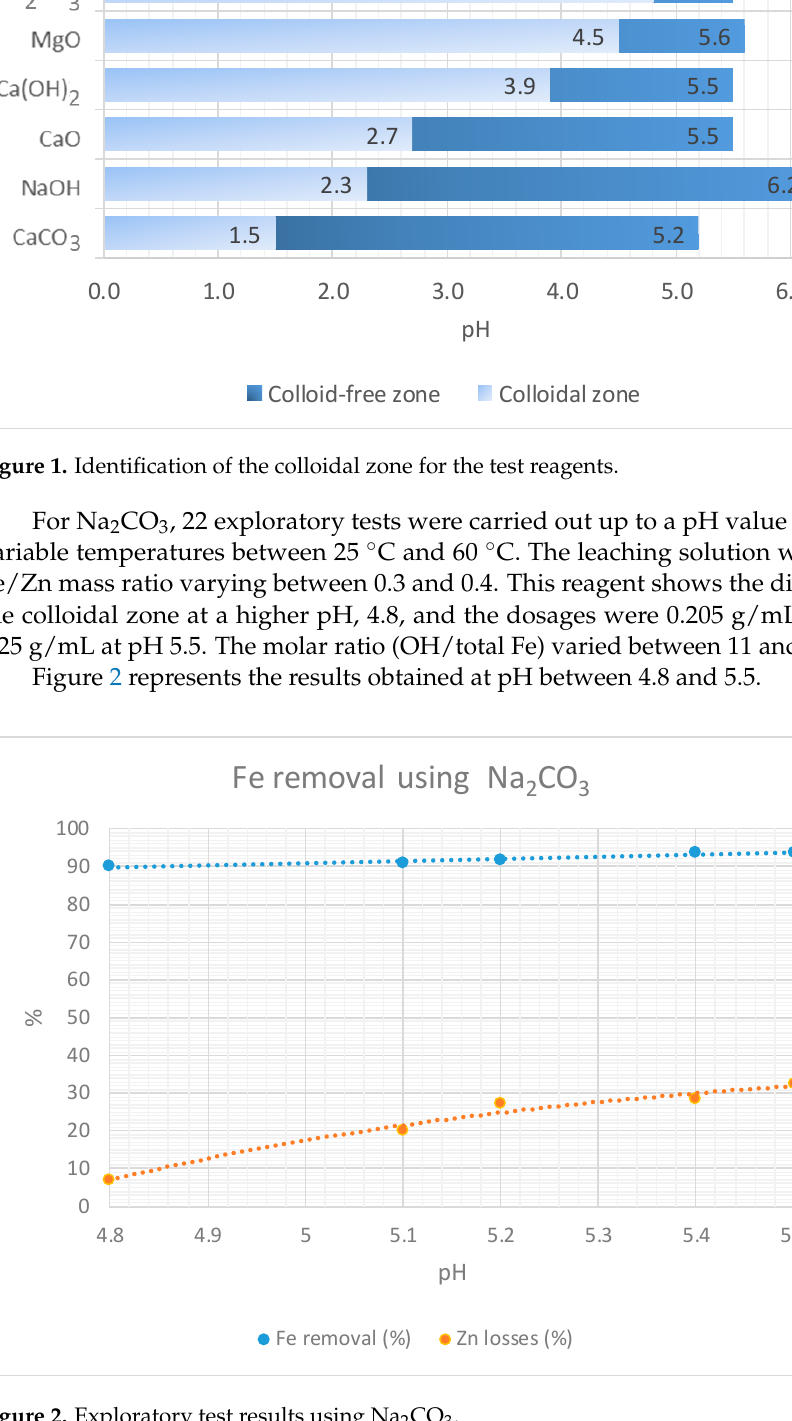
Figure 2. Exploratory test results using Na 2 CO 3.